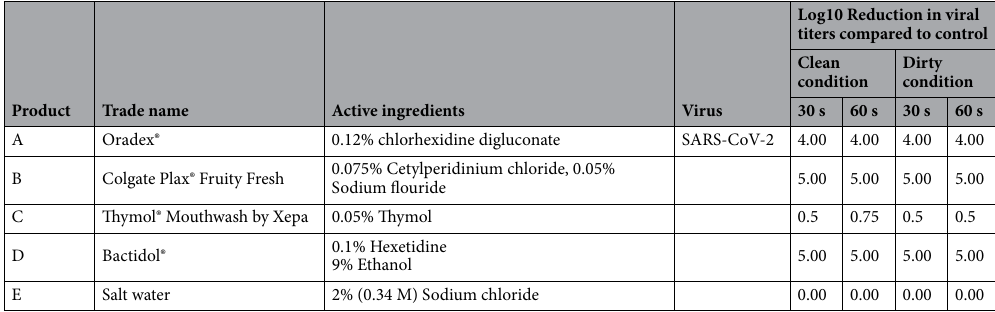
Table 2. Virucidal activity of mouthwash/gargle formulations against SARS-CoV-2.